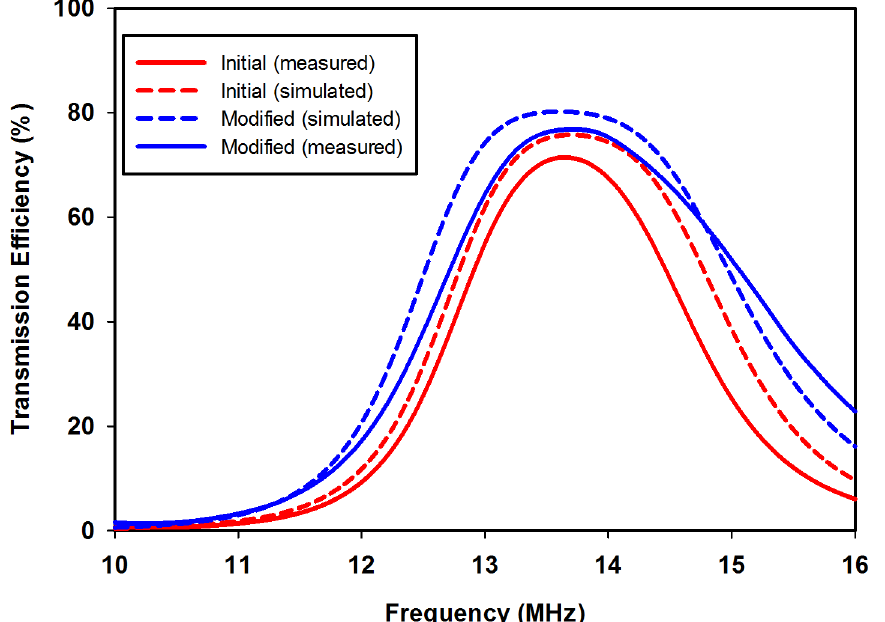
Fig 6. Link transmission efficiencies between planar square loops.